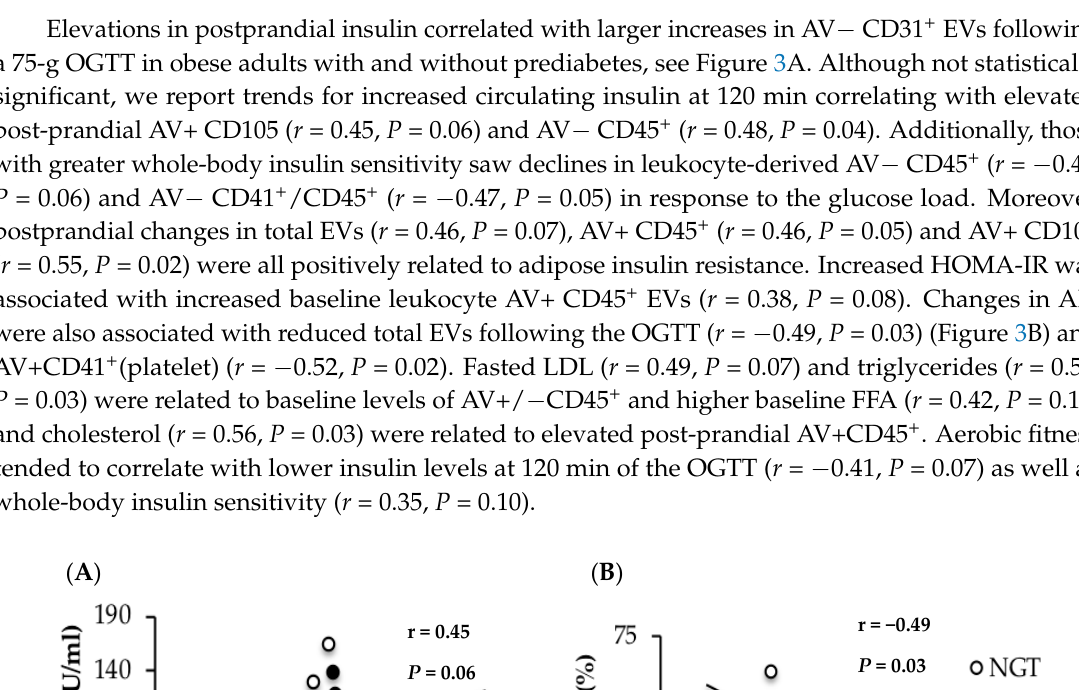
Figure 1. Comparison of changes ( Δ ; fed-fasted) in Annexin V+ (AV+) EV subtype count following an oral glucose tolerance test (OGTT) in NGT vs. prediabetes (PD). EV data were log-transformed. * Time effect, P ≤ 0.05.